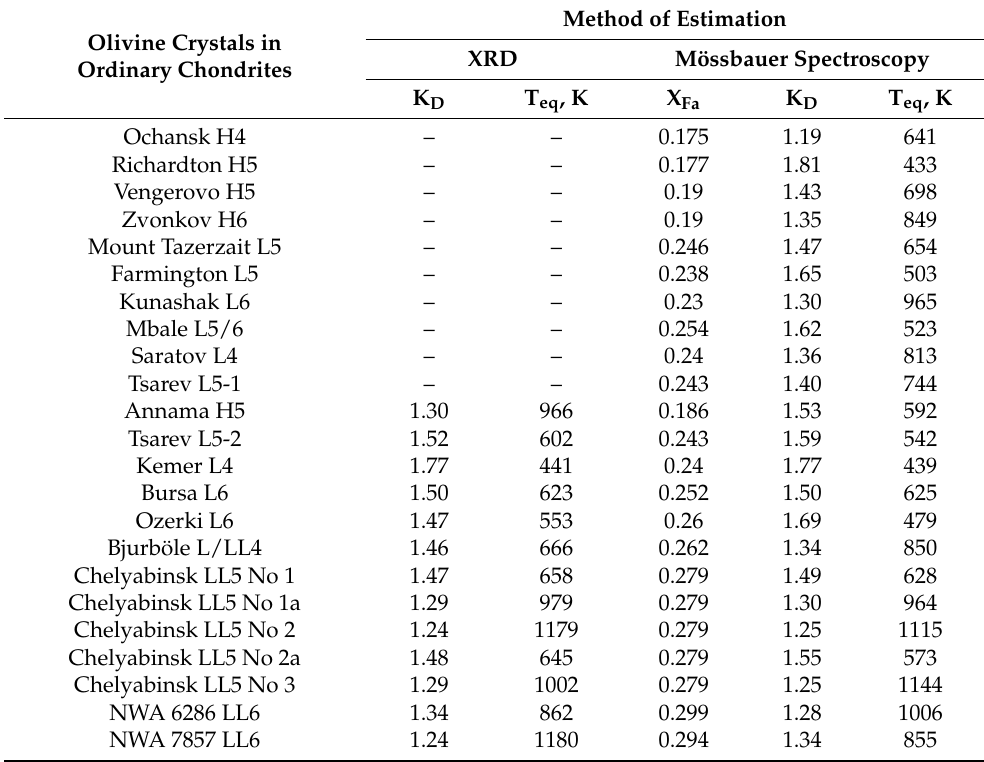
Table 2. The values of the distribution coefficient and the temperature of equilibrium cation dis- tribution in olivine crystals in ordinary chondrites determined by means of X-ray diffraction and Mössbauer spectroscopy (data were taken from References [100,101,107,112]). Method of Estimation Olivine Crystals in XRD Mössbauer Spectroscopy Ordinary Chondrites K D T eq , K X Fa T eq ,